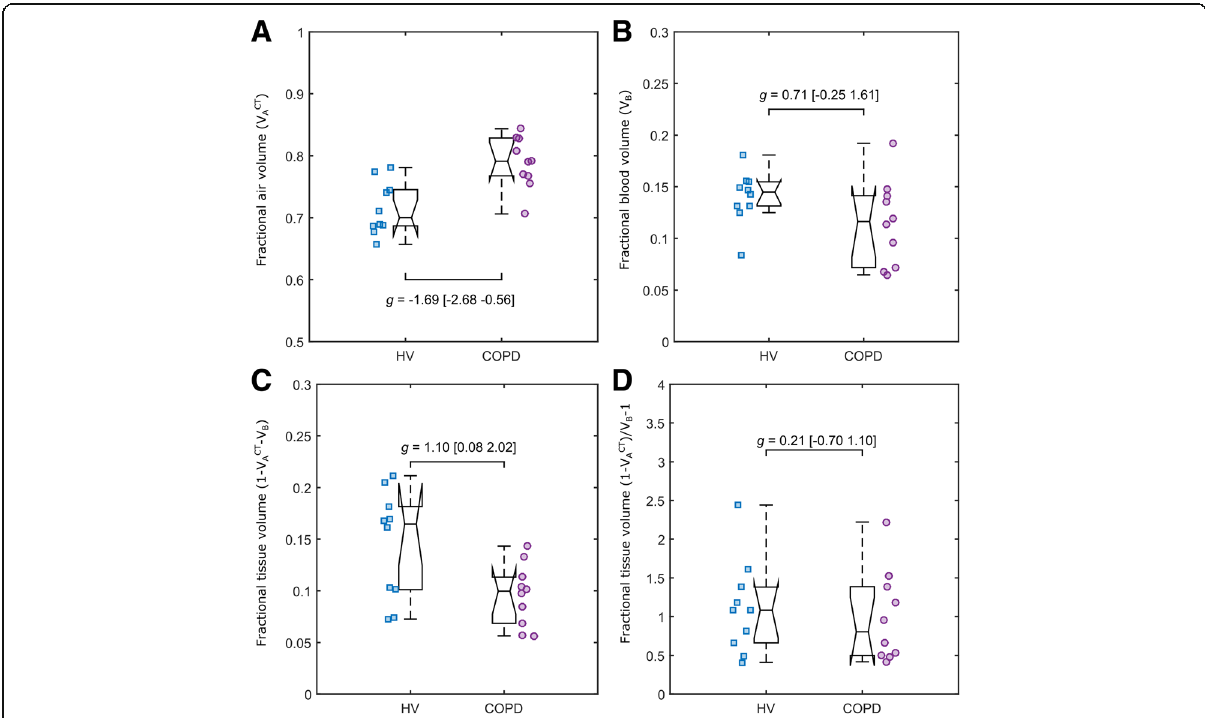
− V B ) ( c ) and tissue to A